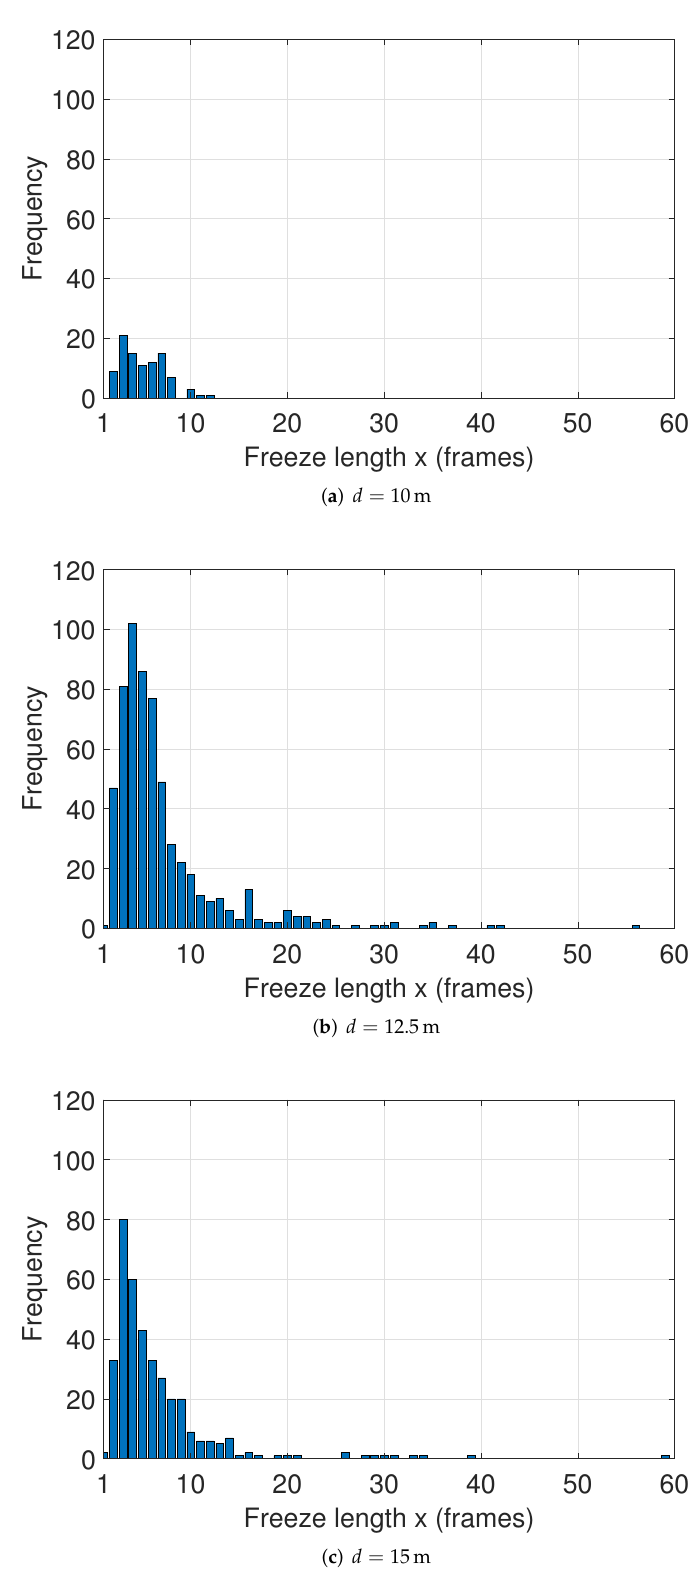
Figure 9. Histograms of freeze length x measured in frames for different transmitter-receiver